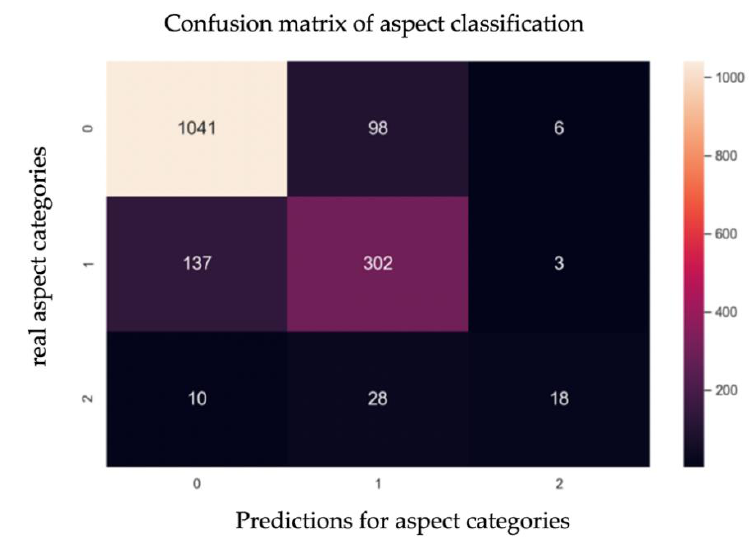
Figure 9. Confusion matrix of aspect classification.